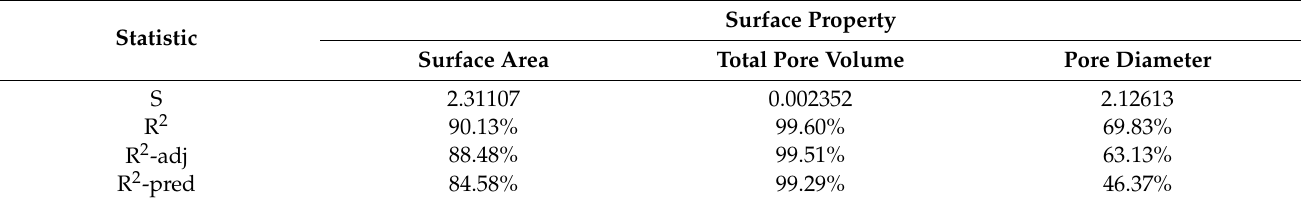
Table 2. Model statistic summary for the surface properties of the nanocomposites throughout the hydrothermal reaction time